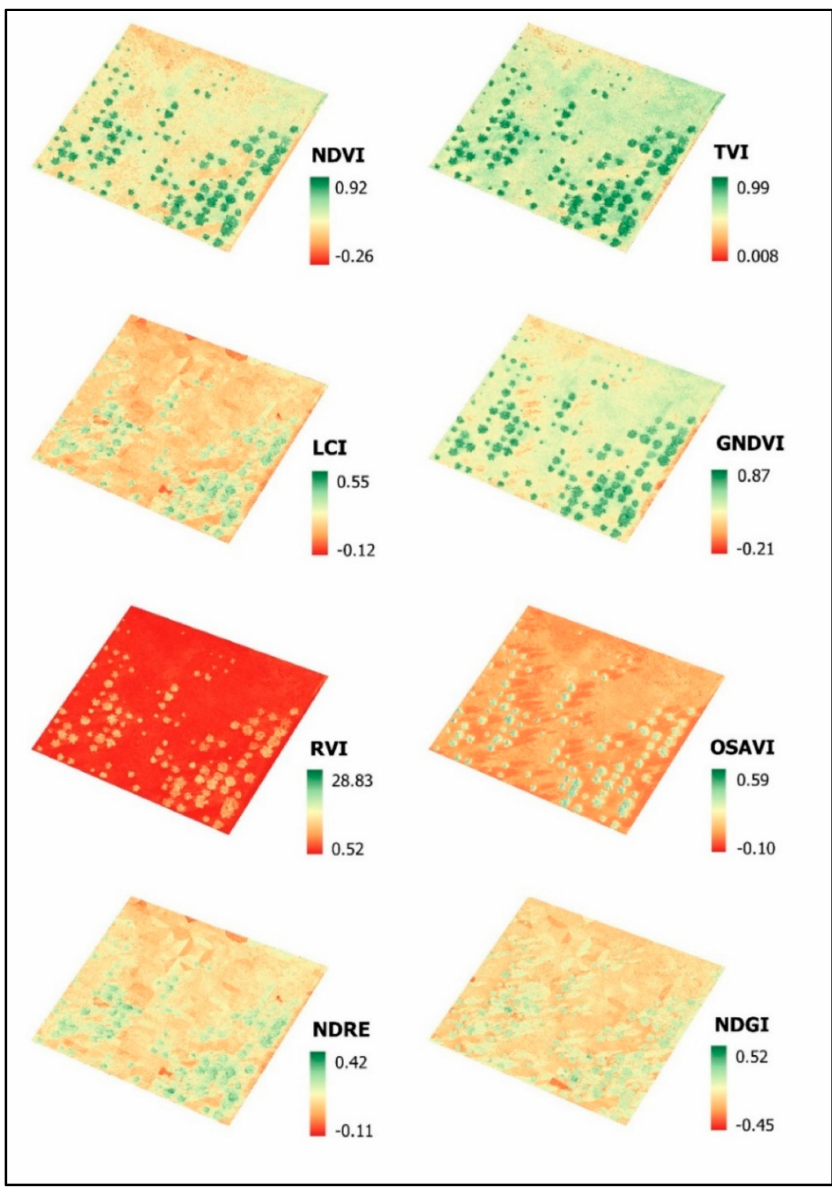
Figure 9. Vegetation indices in Pinus arizonica Engelm. clonal